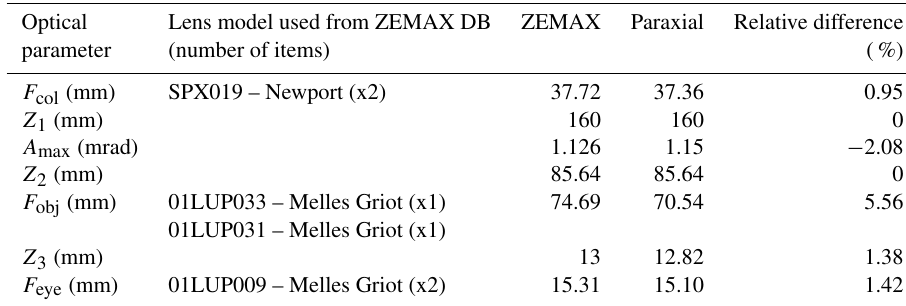
Table 1. The optical parameters (distances and focal lengths) estimated with paraxial approximation and simulated by ZEMAX, along with their relative